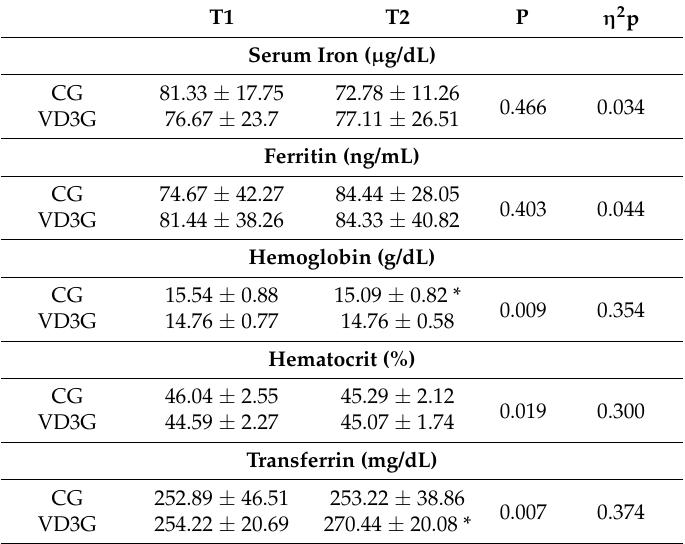
Table 1. Hematological parameters in control group (CG) and vitamin D3 treatment group (VD3G) at baseline (T1) and after 8 weeks (T2).